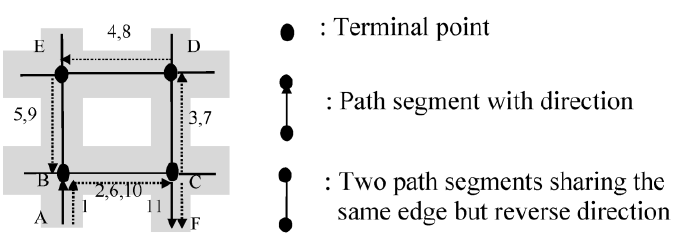
Figure 6. An illustrative example of loop repeat